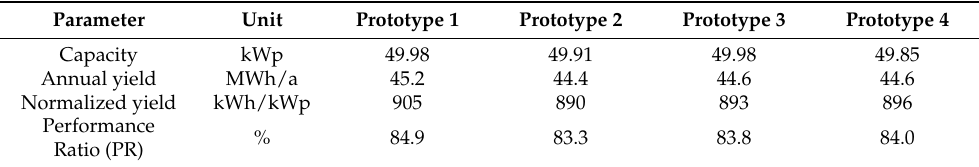
Table 8. Results of simulation in PVsyst for PV systems based on each